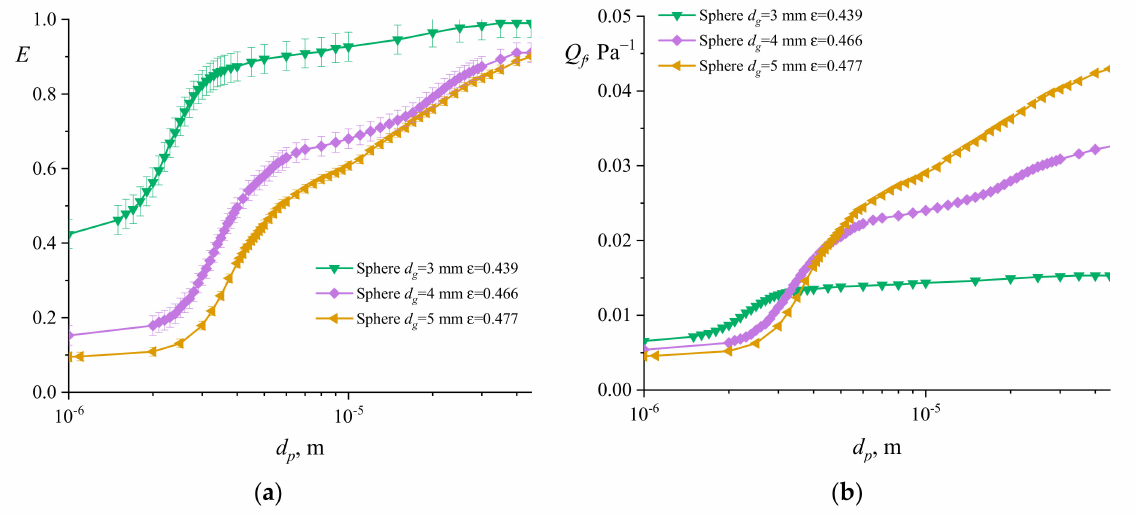
Figure 6. Dependence on the particle diameter: ( a ) particle deposition efficiency; ( b ) filter quality